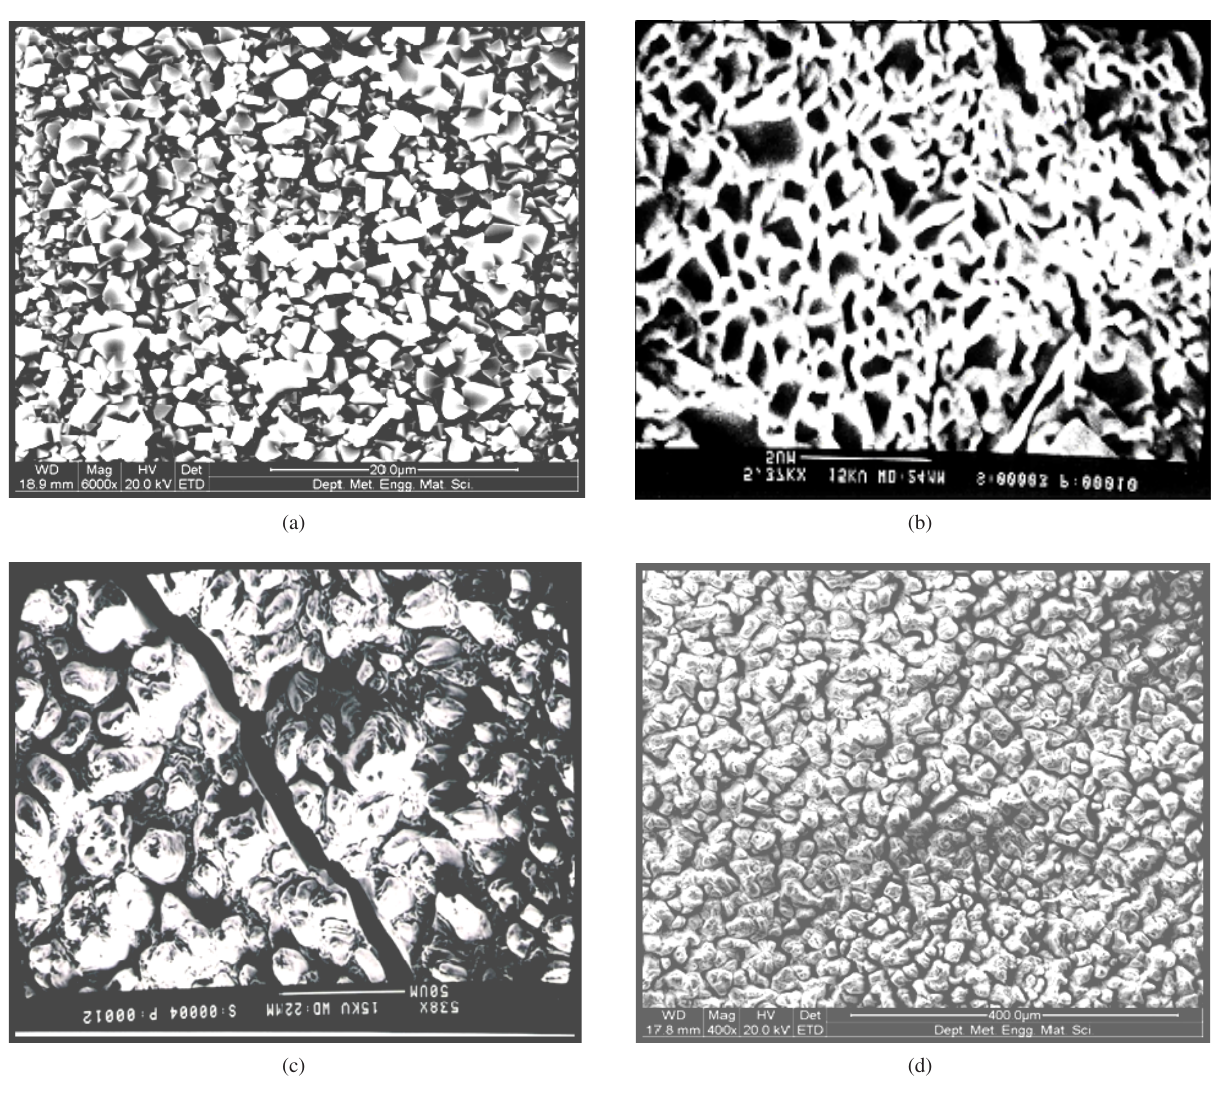
Figure 5. SEM Micrographs of alloys (a), P9, (b) P91, (c) P92 and (d) E911 in air at 1073 for 1000